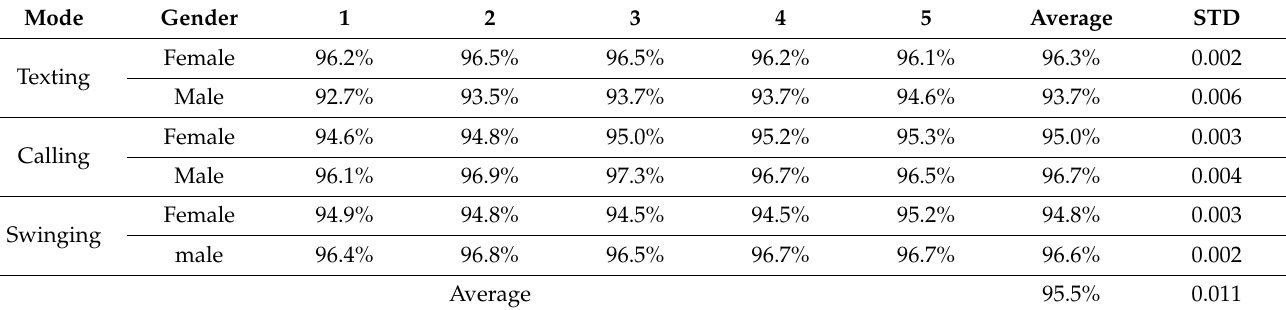
Table 4. Recognition performance of SVM algorithms based on 5-fold